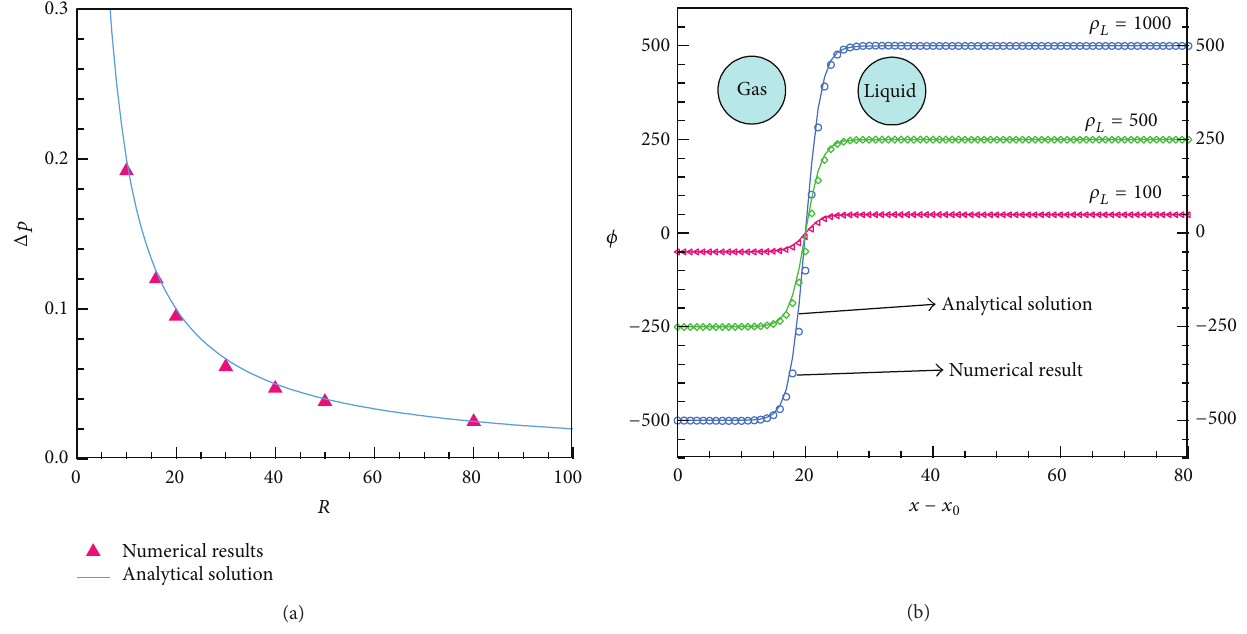
Figure 1: The verification of (a) the Laplace law and (b) the interface